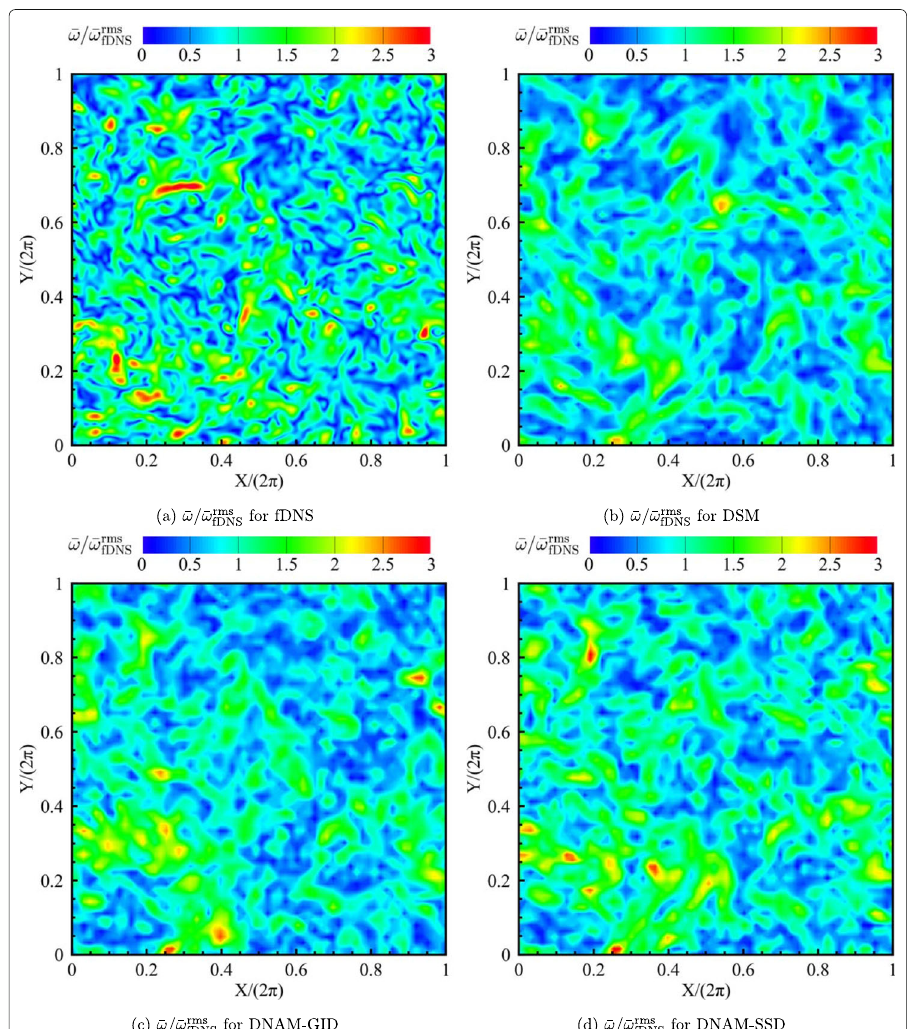
Fig. 11 Contours of the normalized vorticity magnitude at filter scale